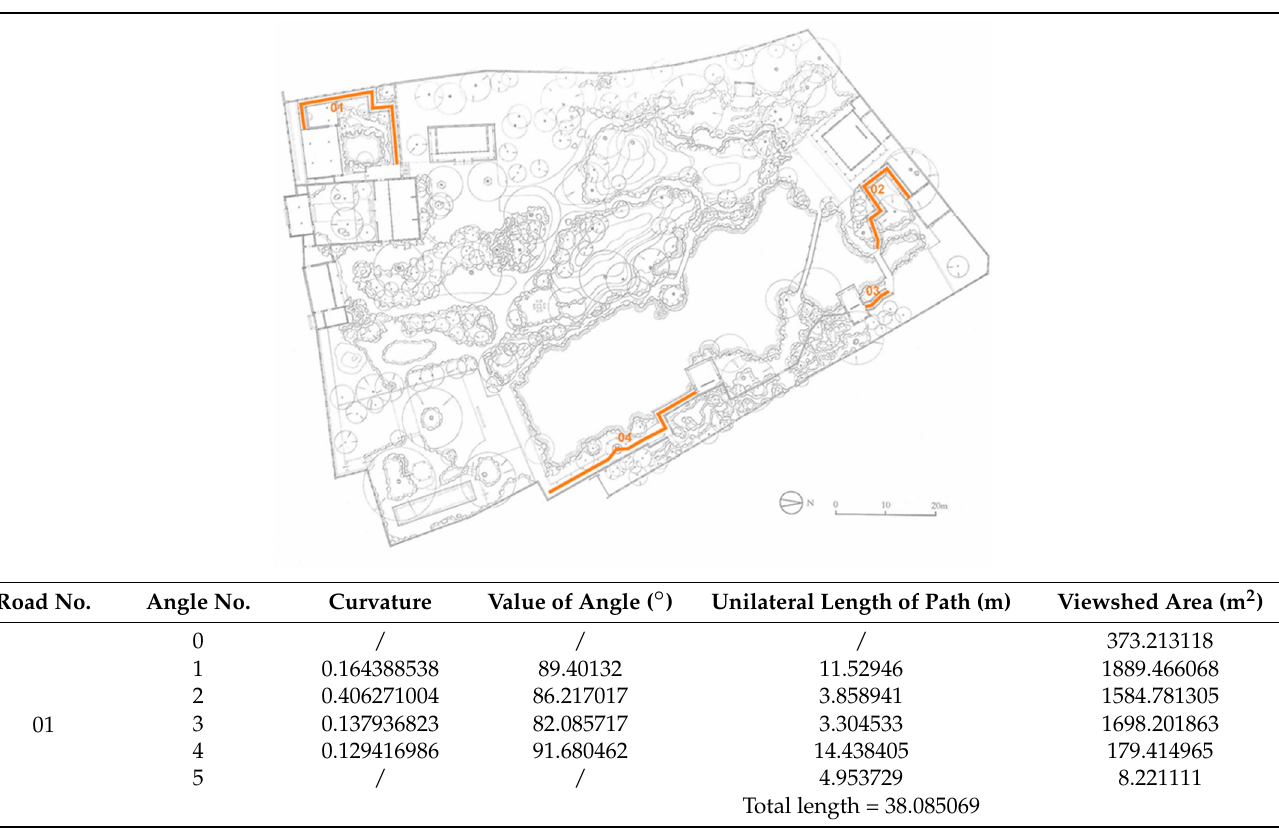
Table A19. Jichang Garden, corridor.